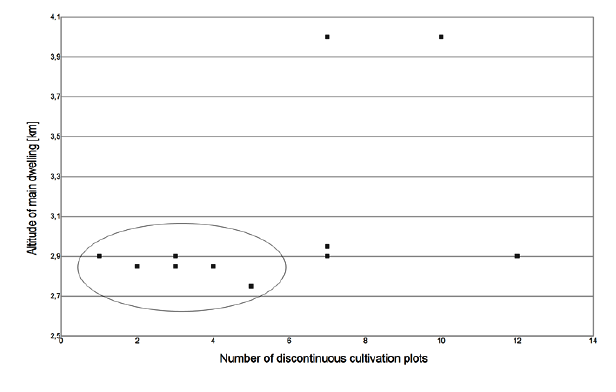
Fig. 4 . Tirani: number of cultivated plots of 11 households in relation with